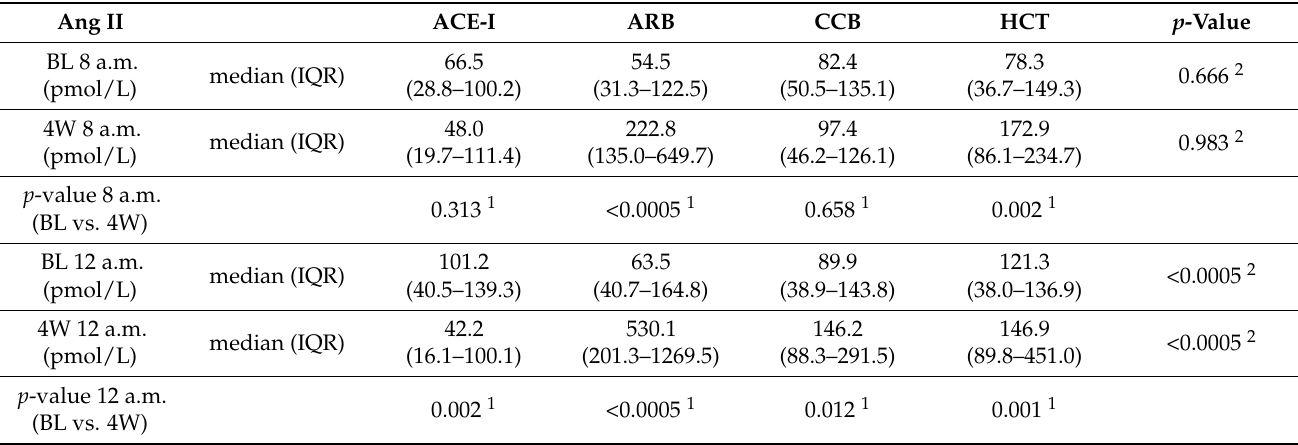
Table 3. Ang II equilibrium concentrations at baseline (BL) and during follow up (4W) in the morning (8 a.m.) and at noon (12 a.m.) for each assigned drug, presented as the median (interquartile range (IQR)).